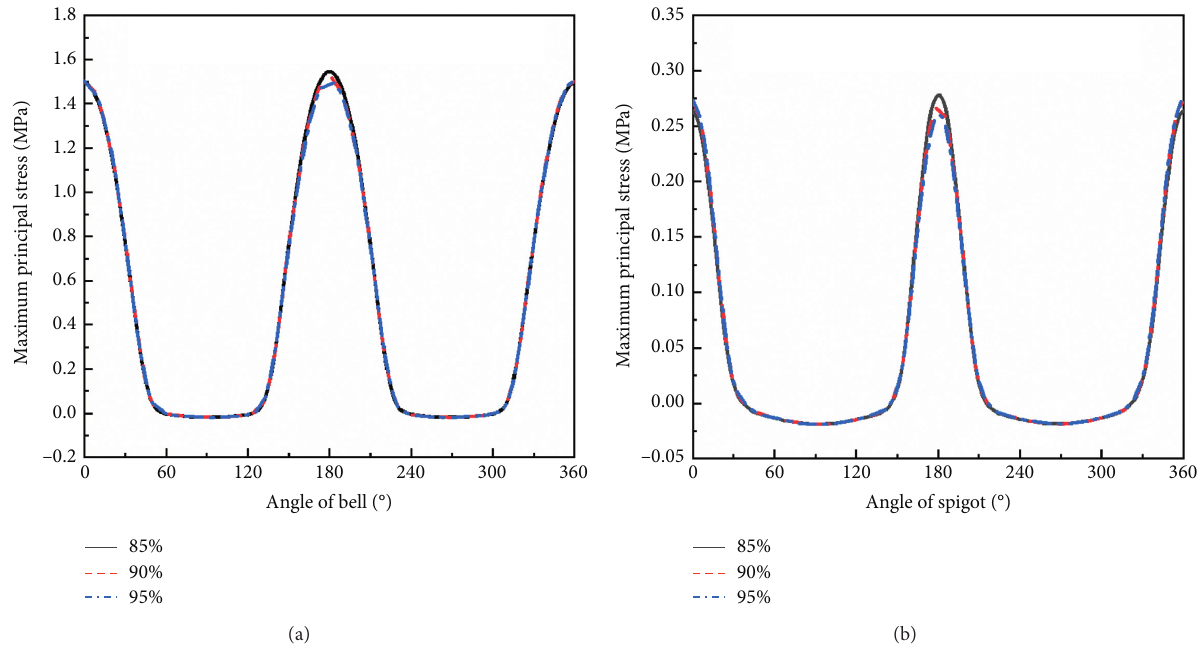
Figure 20: Maximum principal stress of (a) the bell and (b) the spigot under different compaction degrees.